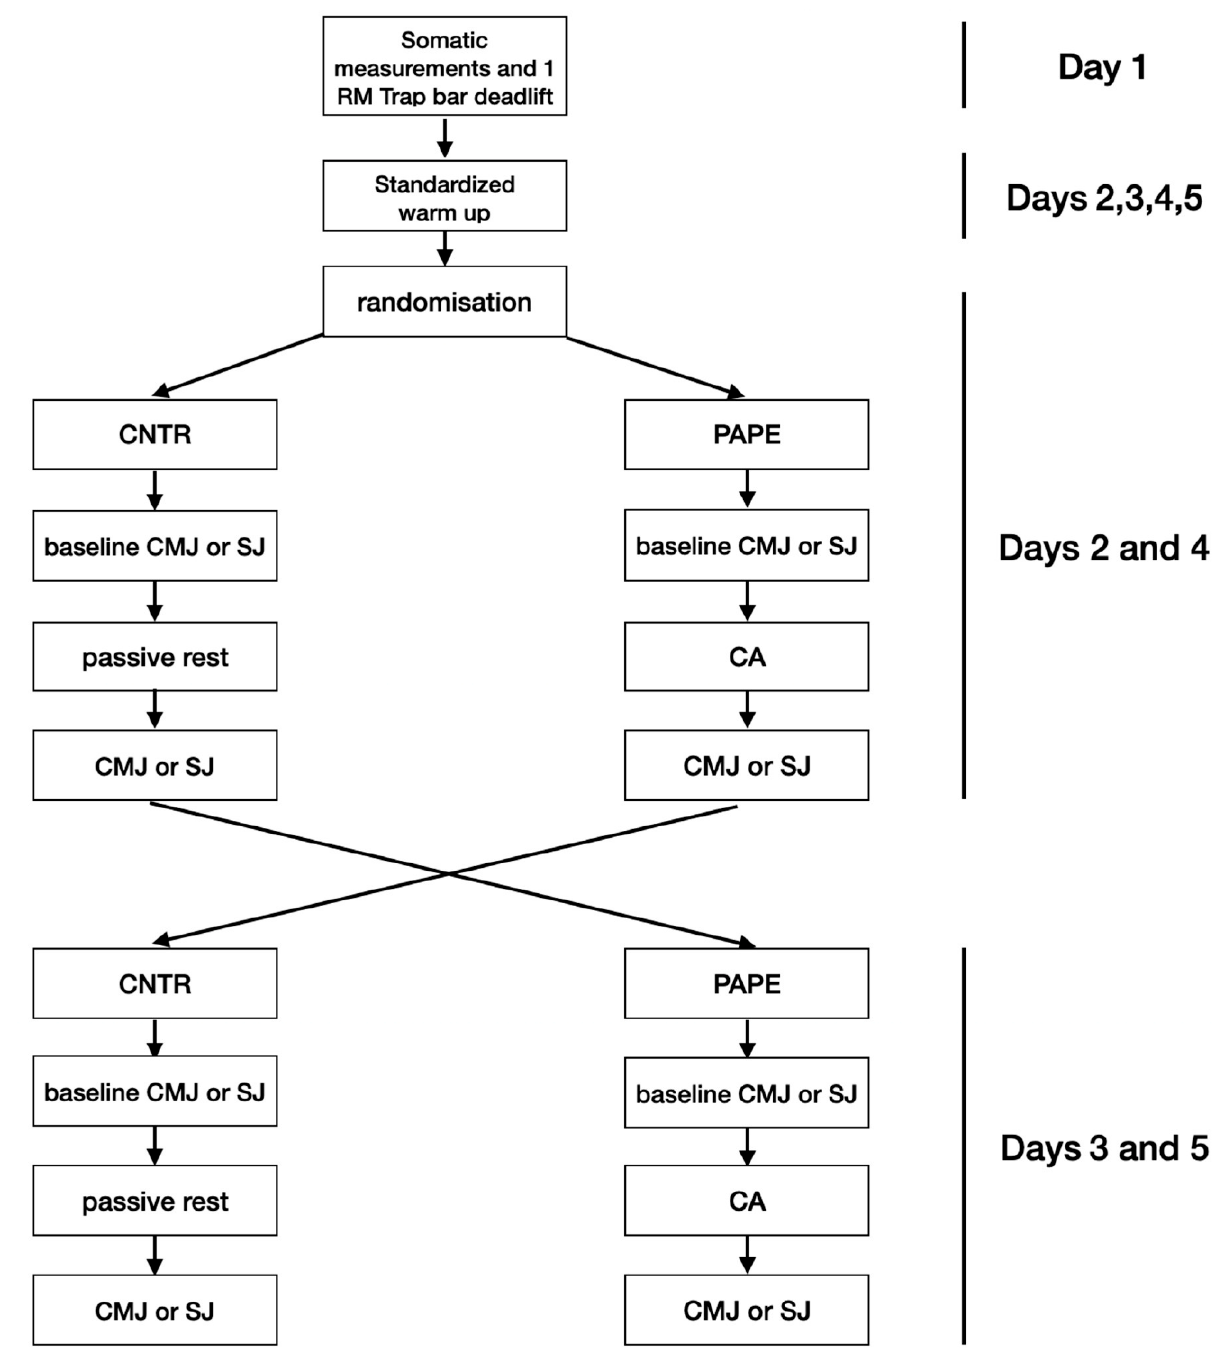
Figure 1. Study design. 1 RM—one-repetition maximum; CNTR—control condition; PAPE—experimental condition, CA—conditioning activity; CMJ—countermovement jump; SJ—squat